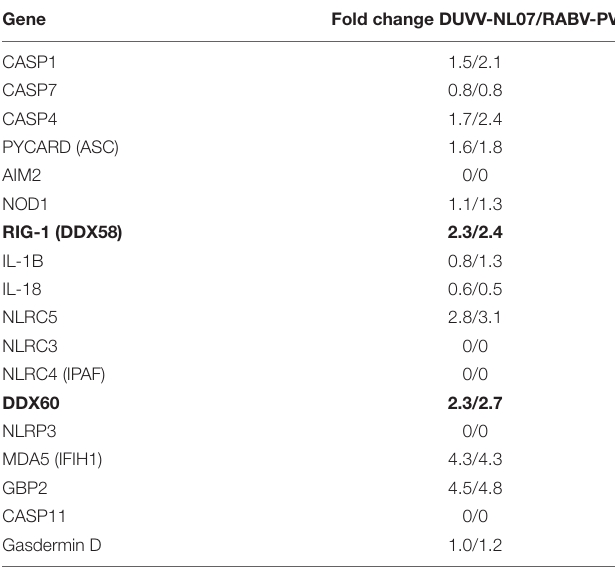
TABLE 3 | Expression levels of genes involved in pyroptotic cell death after DUVV-NL07 and RABV-PV infection of mice.